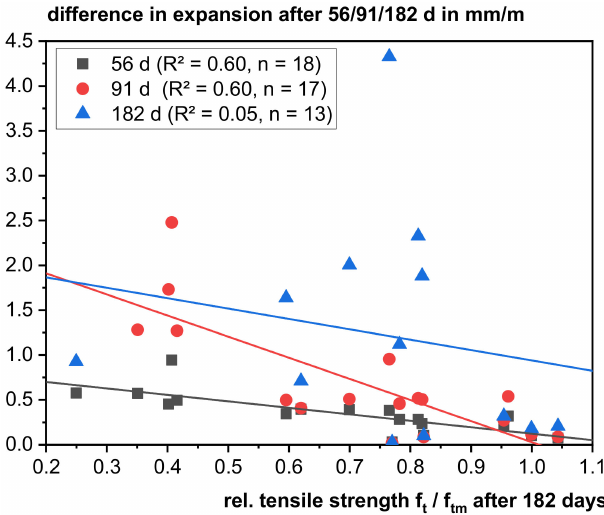
Figure 5. Correlation of the difference in expansion (SVA method, 30,000 mg SO 42 − /L, 20 ◦ C) over the course of time and the relative tensile strength f t /f tm after 182